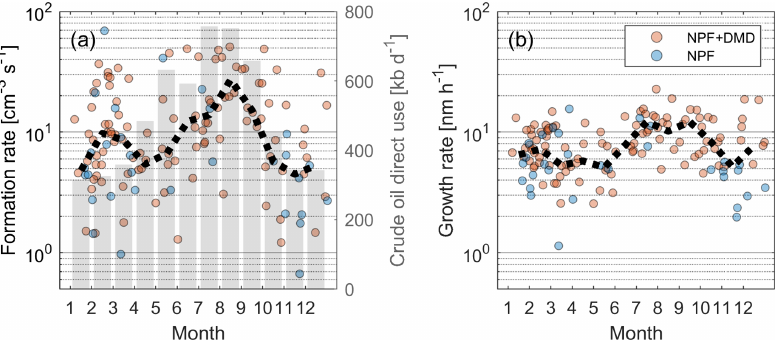
Figure 8. (a) Formation rates ( J 7nm ) and (b) growth rates (GR 7 − 12nm ) for the NPF events observed in Hada Al Sham, separately for DMD days (red circles) and non-DMD days (blue circles). The dashed black line represents the monthly medians. The monthly crude oil direct use (https://www.jodidata.org, last access: 29 July 2019) in panel (a) (grey bars, right Y axis) is calculated as the weighted average of the monthly data from the years 2013–2015. The weighing is based on the number of J values from each year and month.